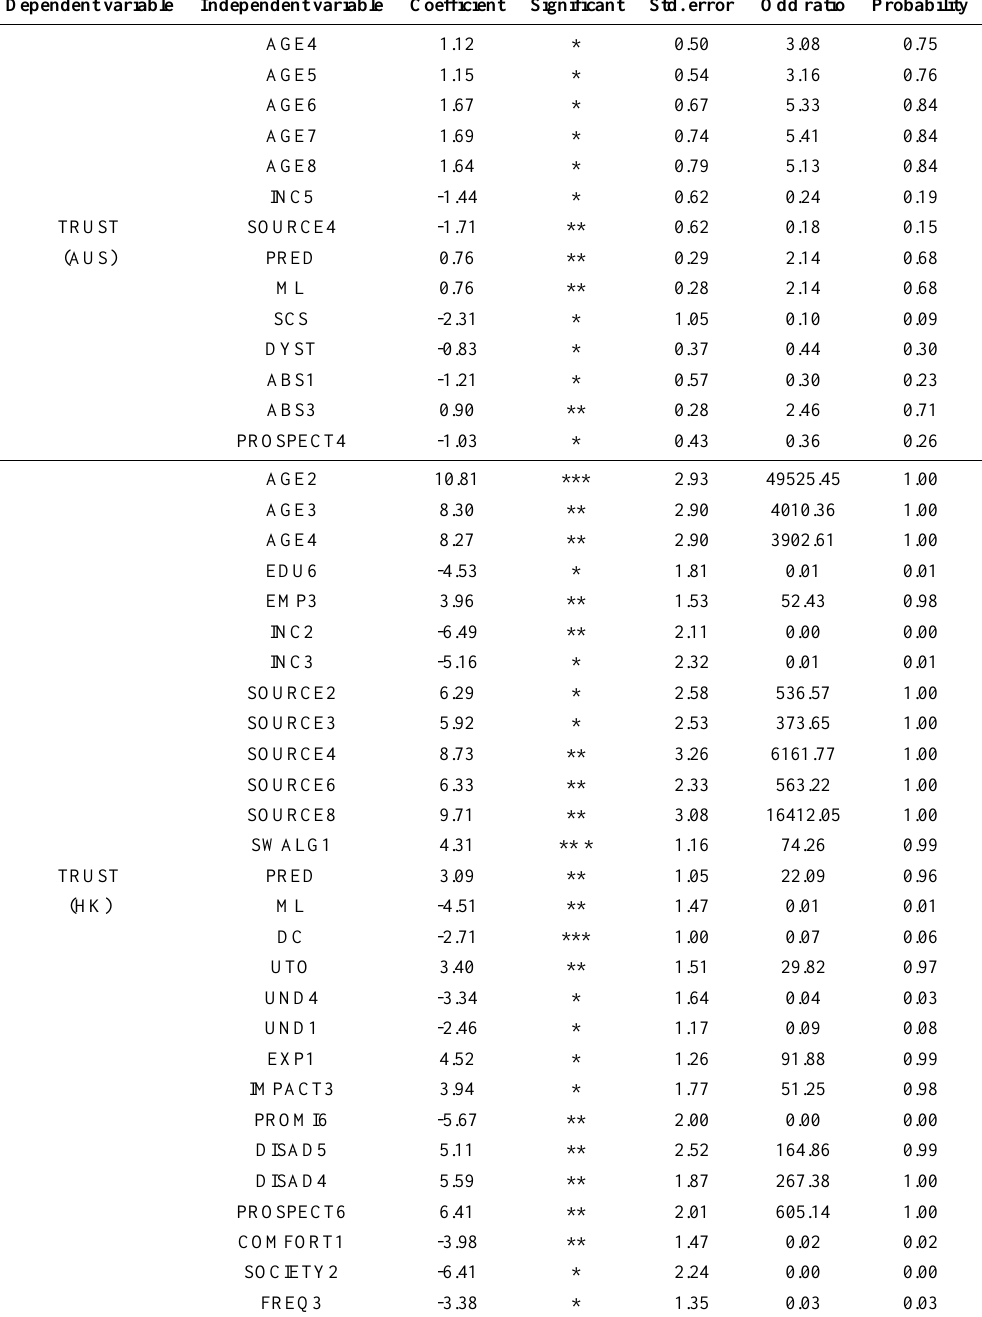
Table B-4. Limited trust of the local community to the AI technology Dependent variable Independent